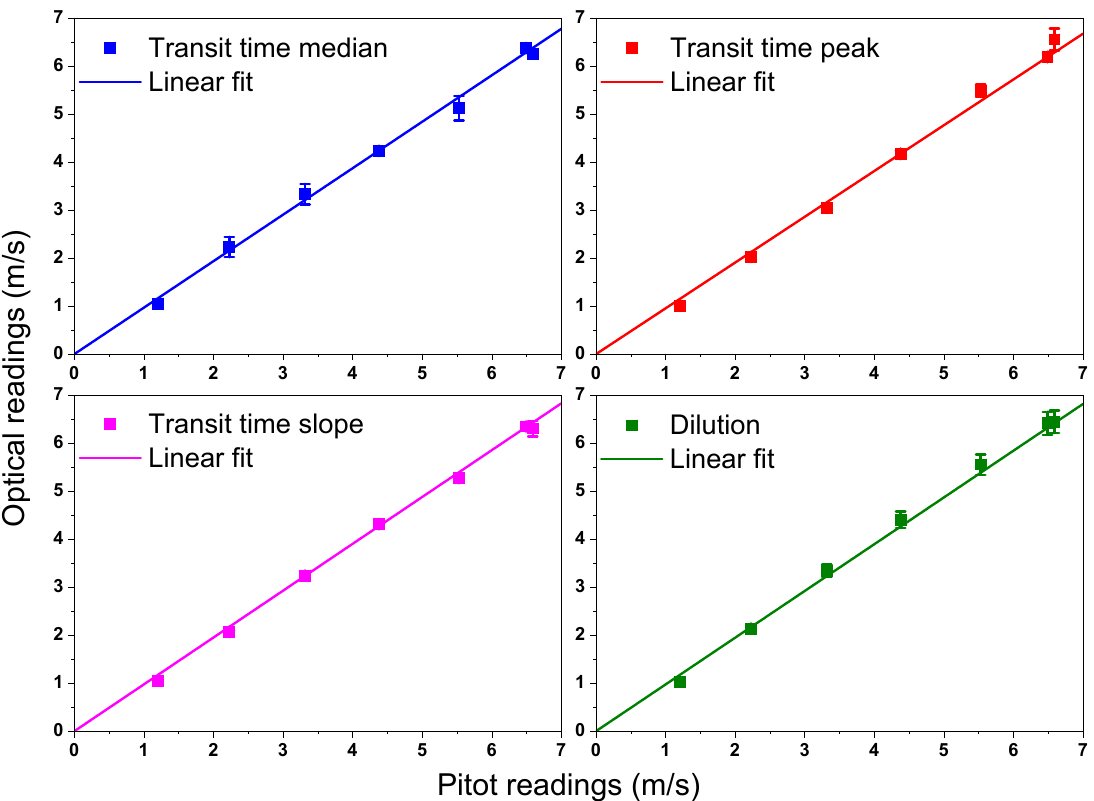
Figure 16. First set of flow velocity measurements, comparing Pitot tube with three different analysis of the TT signals and with dilution. Points are related to different fan